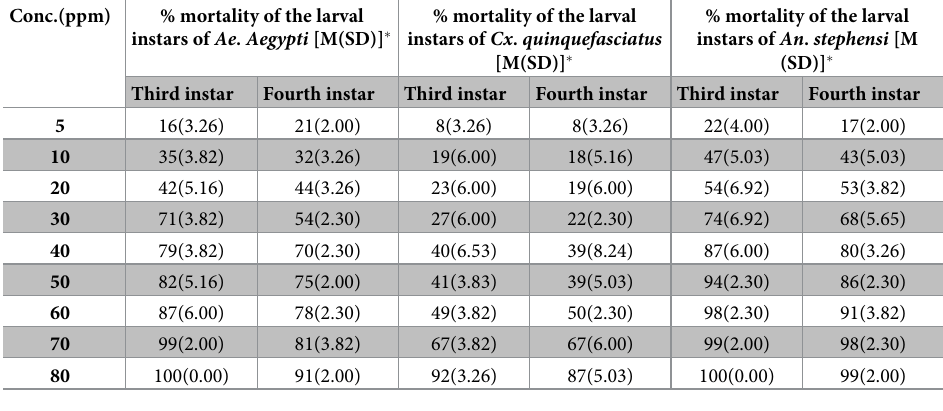
Table) against the egg, pupae and larvae of Ae . aegypti , Cx . quinquefasciatus and An . Stephensi , respectively. The AgNPs synthesized by Bt isolated from soil samples also showed larvicidal activity against the 1 st instar to 4 th instar larvae of Ae . aegypti and Cx . quinquefasciatus [50]. Other bacterial species such as Pseudomonas sp ., Bacillus sp . and Lactobacillus sp . isolated from soil and milk showed larvicidal activity against the larvae of Ae . aegypti . The LC ues of the AgNPs from Lactobacillus sp . were 8.812 μ l/ml and 38.066 μ l/ml, from Bacillus sp . were 0.343 μ l/ml and 1.169 μ l/ml and from Pseudomonas sp . were 0.473 μ l/ml and 1.266 μ l/ml [52]. The significance of the study was statistically tested using the Graphpad Prism 8 software. Table 6. Larvicidal Activity of AgNPs synthesized by Bacillus marisflavi against Ae . aegypti , Cx . quinquefasciatus and An . stephensi